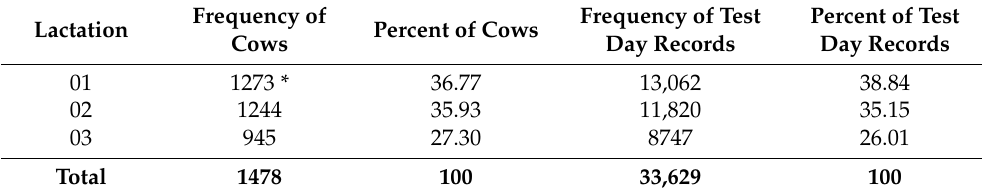
Table 2. The number of genotyped cows and the number of test day records by breed type. Frequency of Test Percent of Test Frequency of Percent of Cows Breed Type Day Records Day Records Cows H0 1393 94.25 32,172 95.67 H1 41 2.77 2.50 24 Total